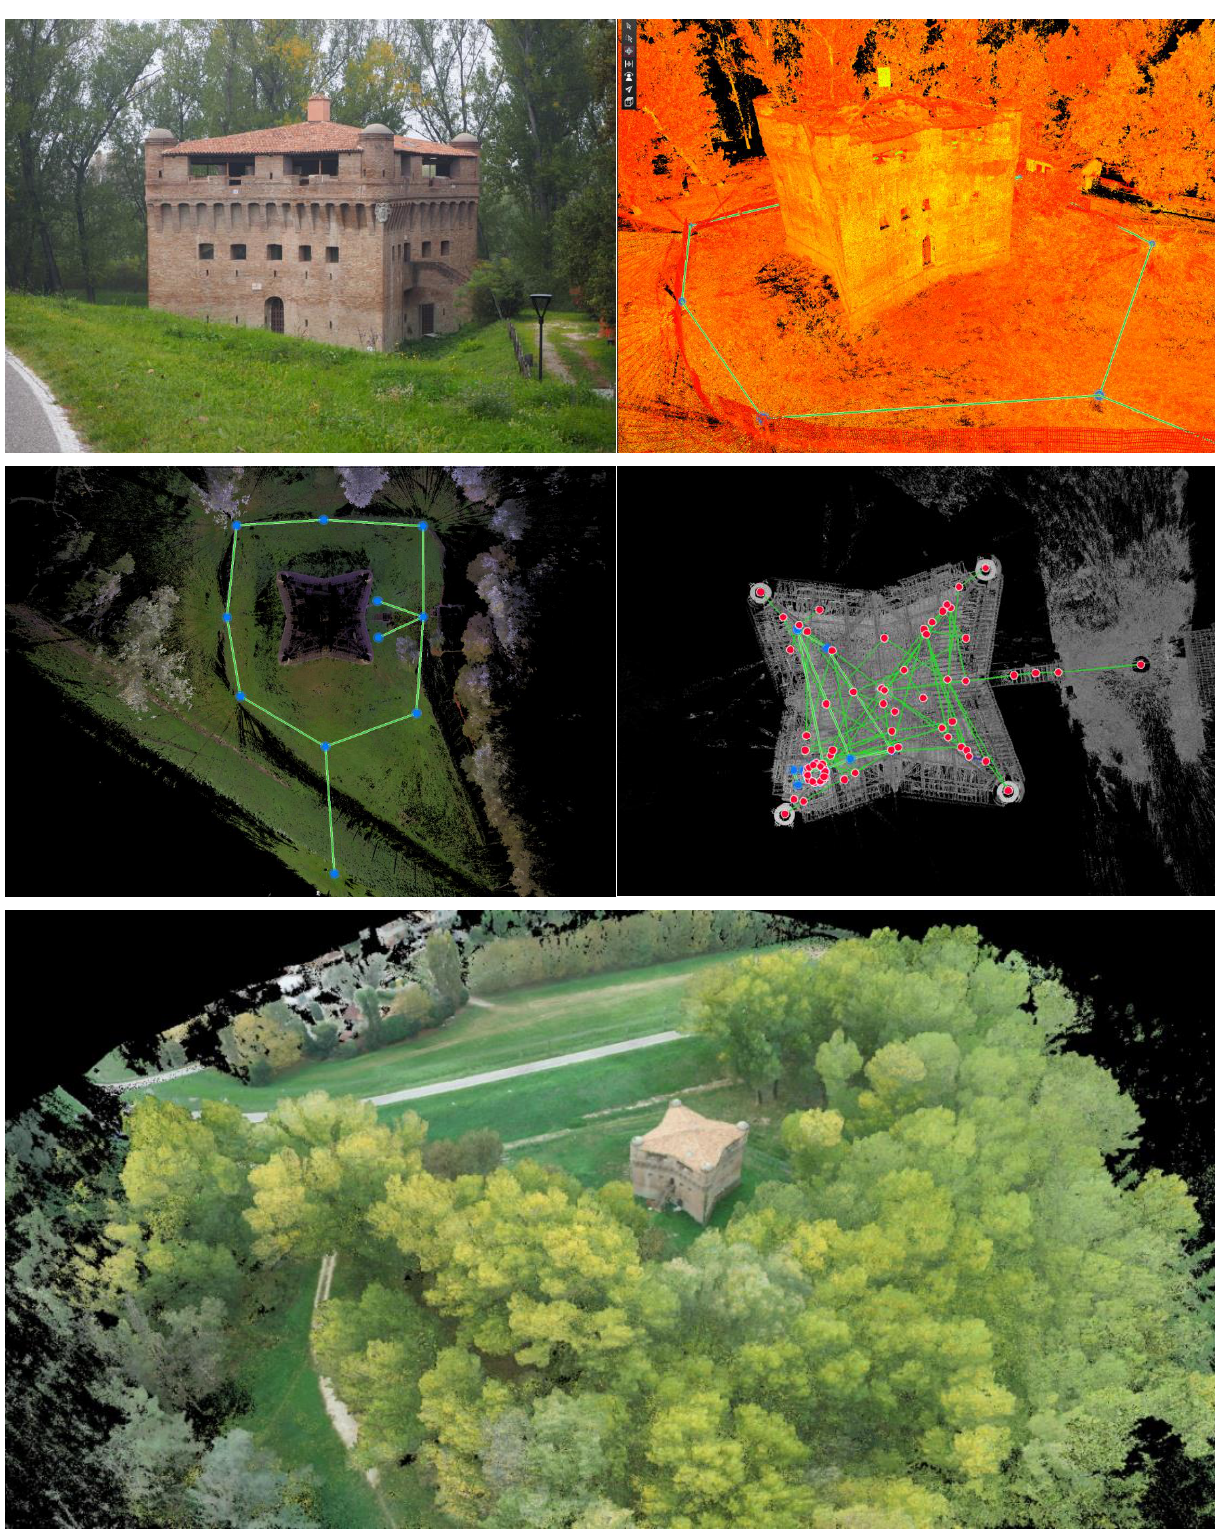
Figure 2. Integrated three-dimensional digital survey of earthquake-damaged cultural heritage. Rocca Possente, Stellata,